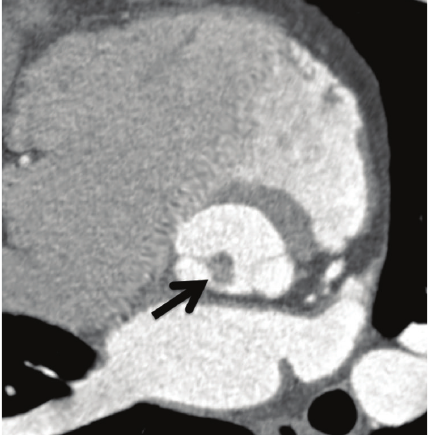
Figure 3: Papillary fibroelastoma of the aortic valve: a round-shaped hypodense mass . The mass is attached to the noncoronary cusp (black arrow). Cross-sectional view of the aortic